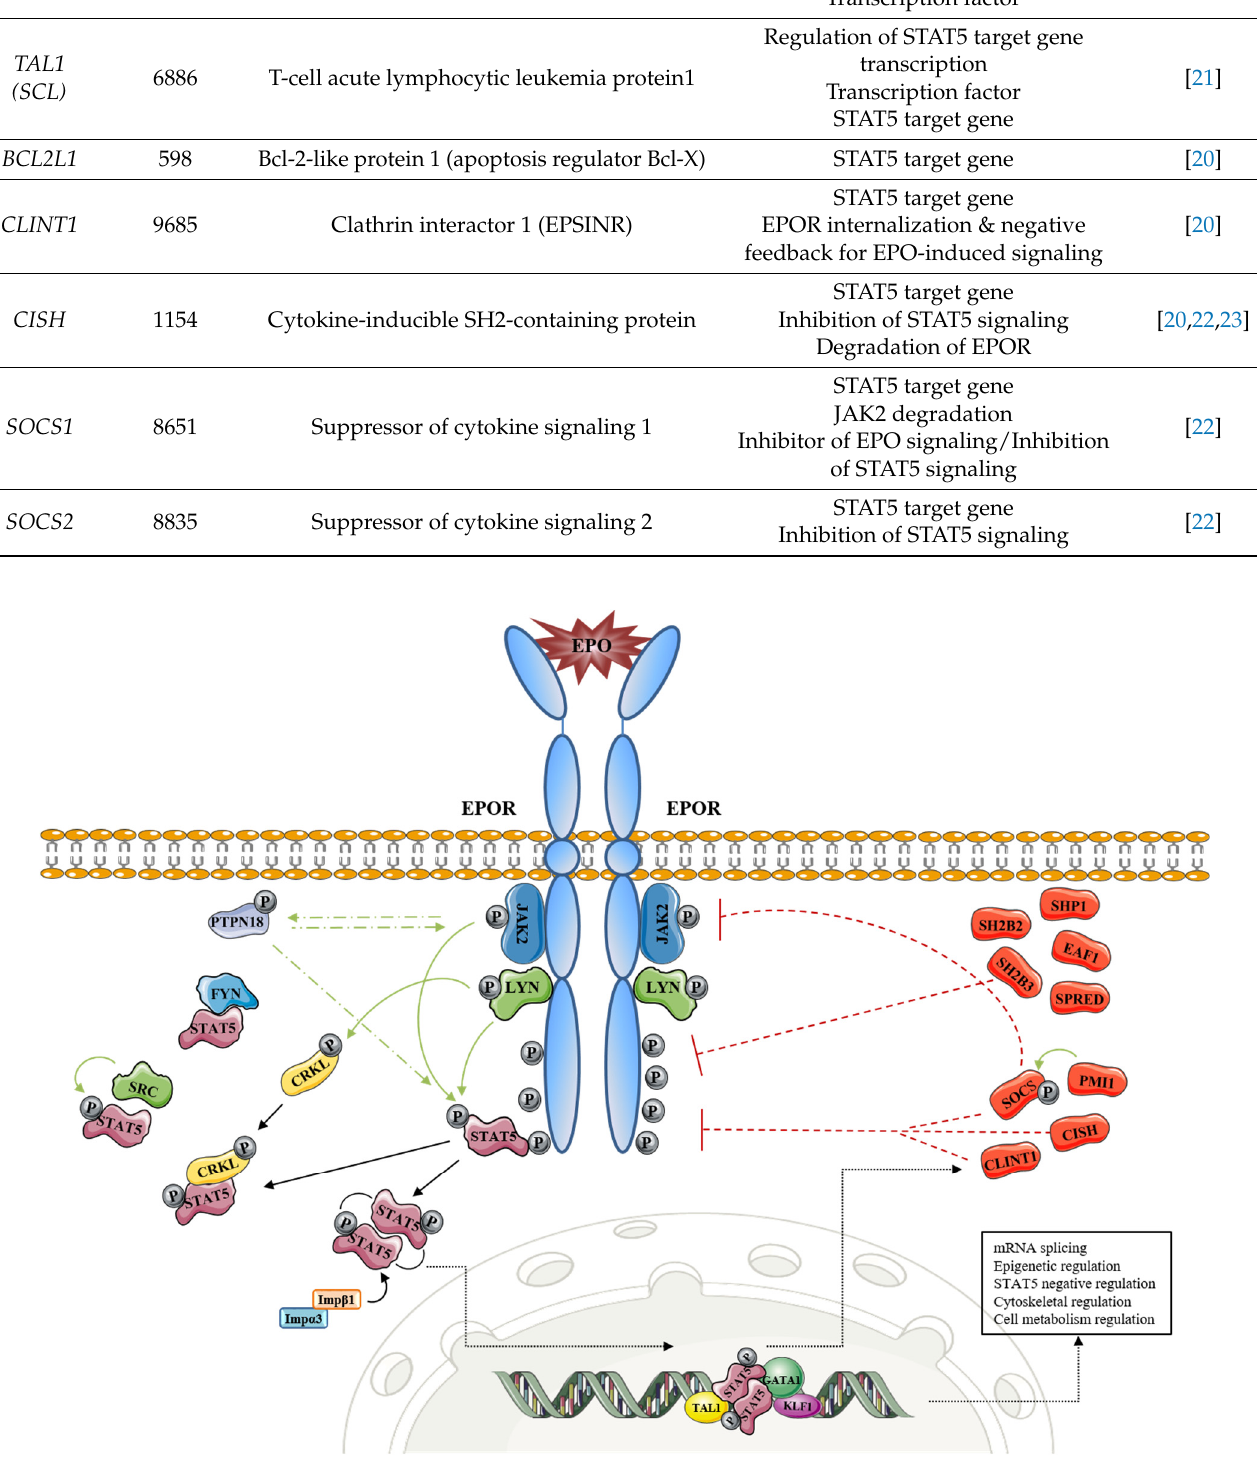
Figure 1. EPOR-STAT5 signaling and its involvement in processes other than inhibition of apoptosis, cell cycle progression, and cell cycle arrest. Green line: activation effect (phosphorylation); red line: inhibition effect; black line: transition. Table 1. Main players of JAK2/STAT5 signaling cascade .